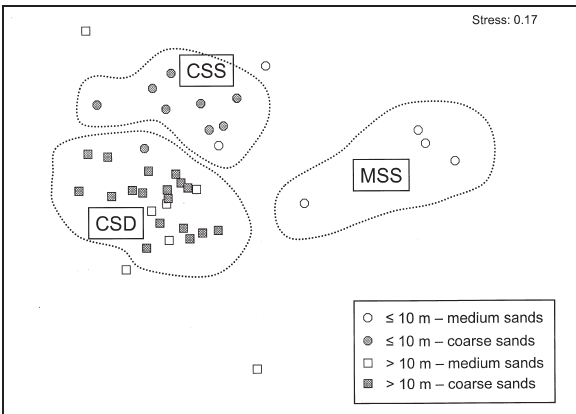
Fig . 4. – Results of the Multi-Dimensional Scaling (MDS) showing the groups detected by cluster analysis (MSS (Medium Sand Shal- low), CSS (Coarse Sand Shallow) and CSD (Coarse Sand Deep)). Samples have been classified into four classes: shallower or deeper than 10 m (circles and squares respectively), and according to their dominant granulometry (coarse (black) or medium (white) sands).